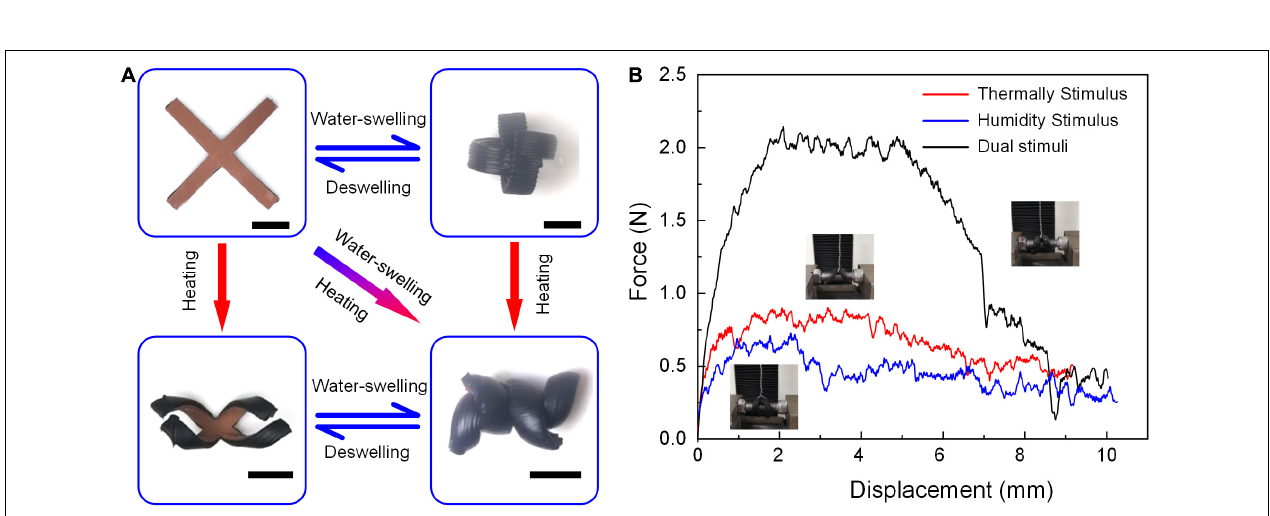
FIGURE 12 | Transformable soft gripper. (A) Deformation of a PU-SMPVC bilayer structure in a crisscross shape with an angle of 45 ◦ in the radial direction of the SMPVC layer in response to different stimuli. (B) The relationship between the desorption force and displacement generated by three soft grippers with different shapes in the process of gripping a fixed